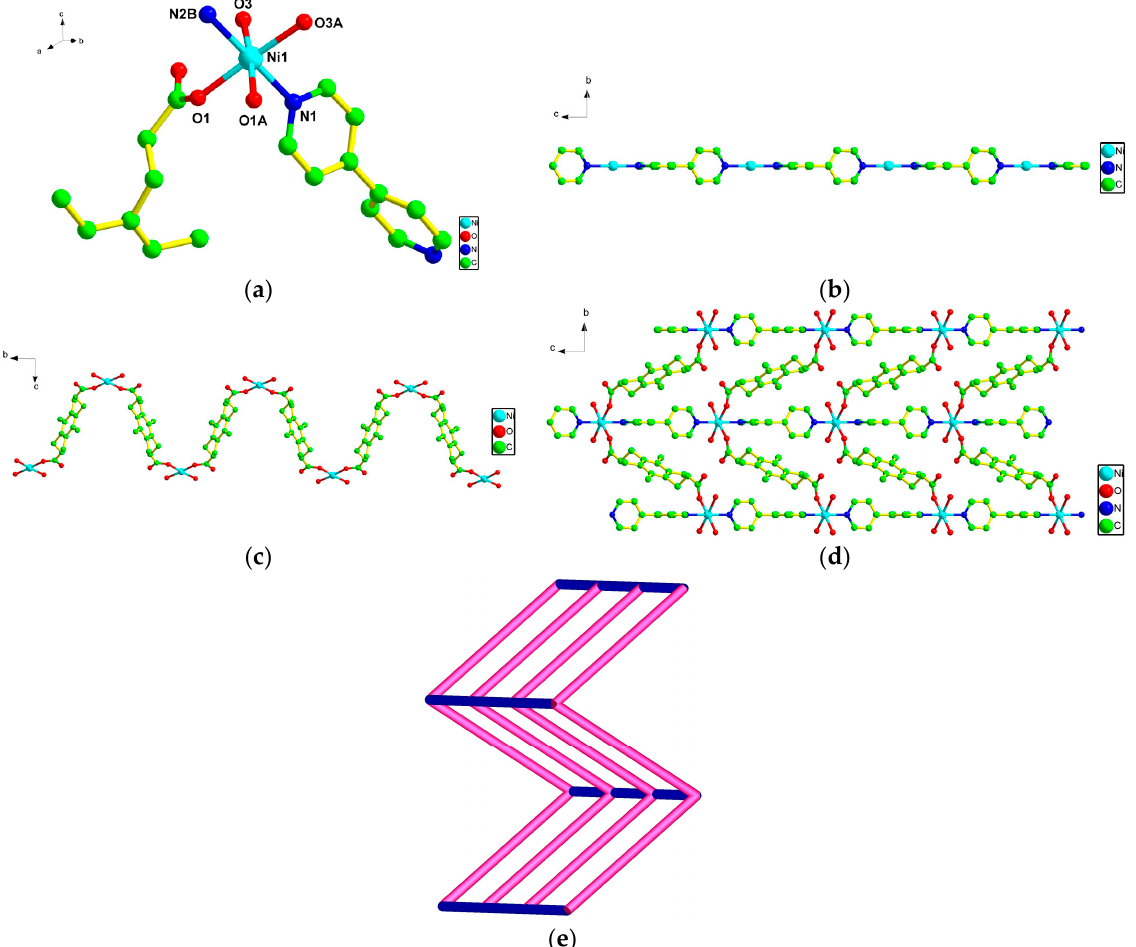
Figure 4. ( a ) Surrounding environment map of Ni(II) in complex 4 , symmetric opcode: A = x, 0.5 − y, z; B = 1 + x, y, 1 + z. ( b ) Ni(II)/X 2 − 1D chain. ( c ) Ni(II)/4,4 ′ -bpy 1D chain. ( d ) The 2D structure B = 1 + x, y, 1 + z. ( b ) Ni(II)/X 2 − 1D chain. ( c ) Ni(II)/4,4 (cid:48) -bpy 1D chain. ( d ) The 2D structure diagram diagram of complex 4 . ( e ) Schematic view of the 2D topology network for 4 . of complex 4 . ( e ) Schematic view of the 2D topology network for 4